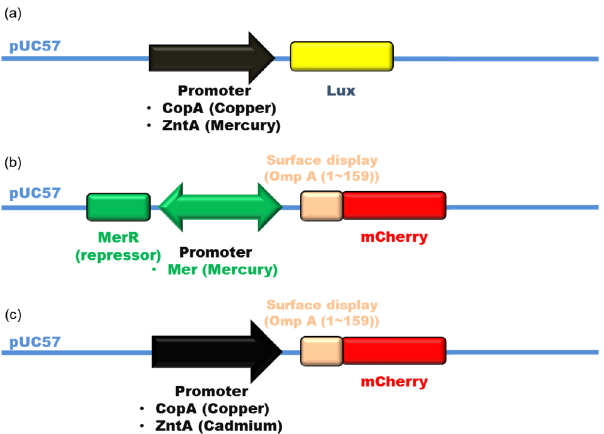
Figure A1. Whole metal-sensing plasmid modules. ( a ) pCopAp-Lux and pZntAp-Lux. ( b ) pMerp-